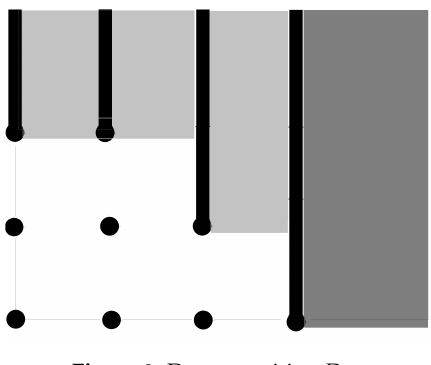
Figure 2. Decomposition D 2